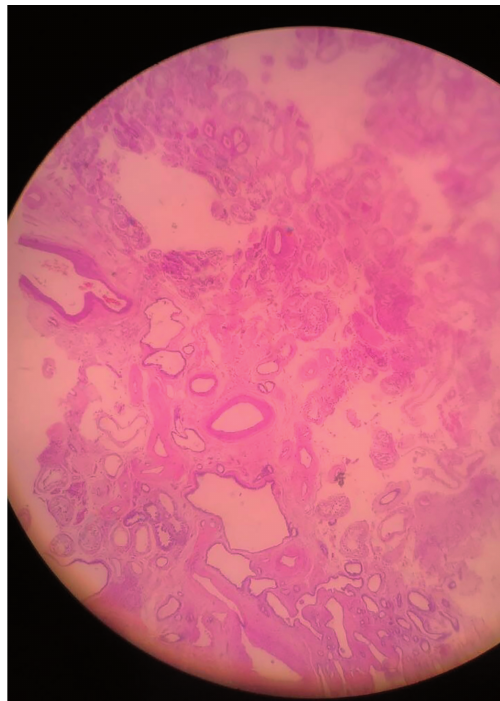
Figure 5 - Calretinin antibody (4x).